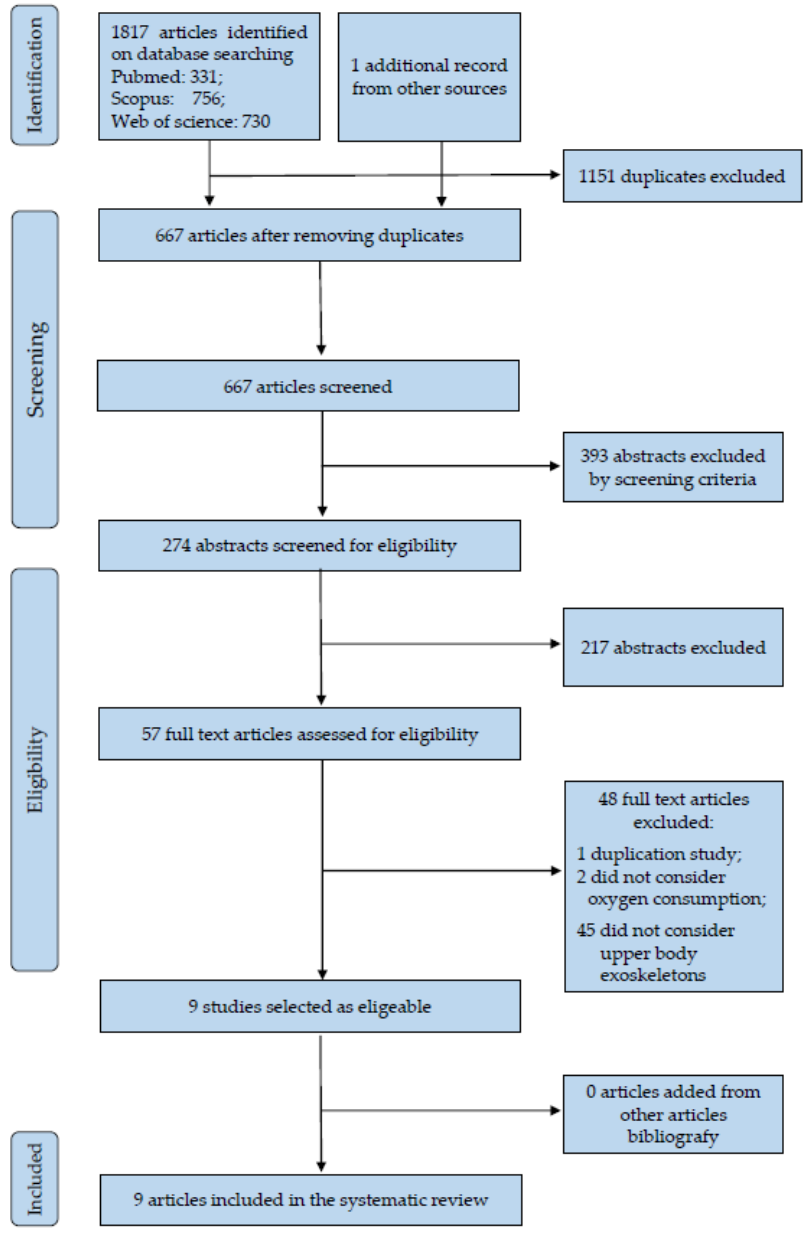
Figure 1. The flowchart of the study selection process.